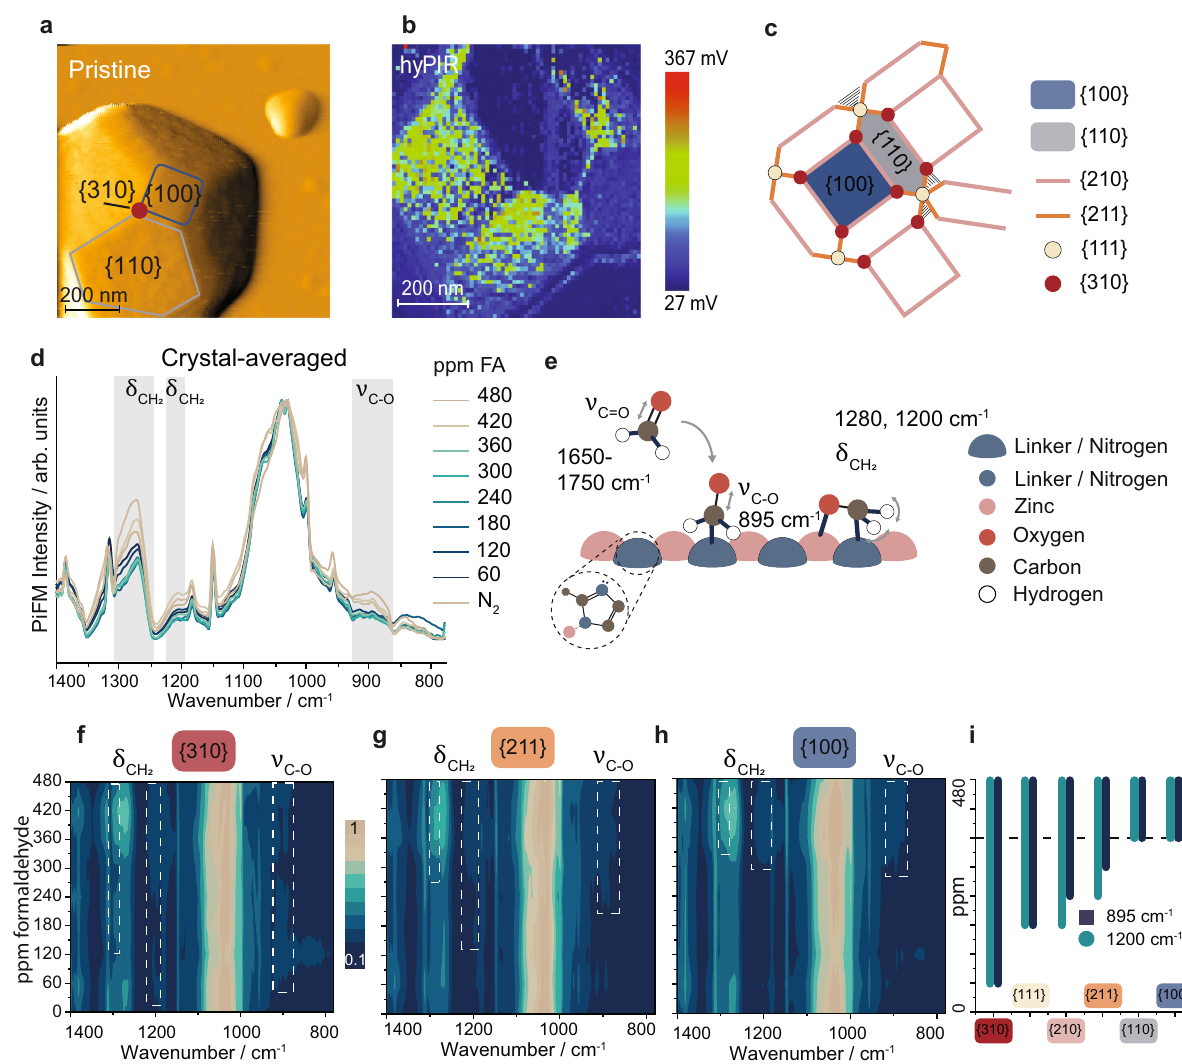
Fig.2|Experimentalevidenceofstructure-sensitiveformaldehydesorptionon ZIF-8.a Anatomicforcemicroscopy(AFM)imageofZIF-8showstheexpressionof different crystal planes. b Hyperspectral images, with a full IR spectrum at every pixel,of such ZIF-8 crystalswere recorded during formaldehyde exposure. Overall spectrum intensity per pixel is denoted in mV. Individual planes within these ima- ges were analyzed by ( c ) creating morphology-based masks. d Crystal-averaged PiFM spectra at increasing formaldehyde (FA) pressure show the increase of three